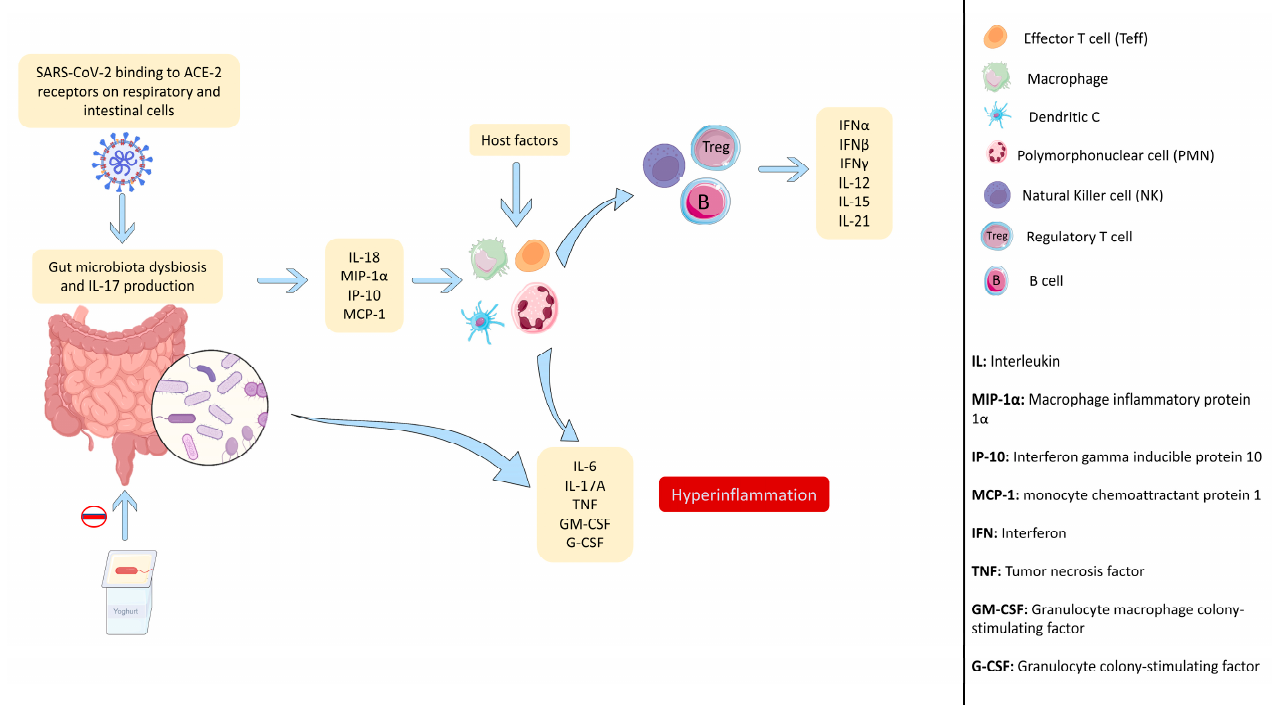
Figure 4. Mechanism of action of probiotics against SARS-CoV-2 infection. SARS-CoV-2 binds to ACE2 respiratory and intestinal cell receptors, producing dysbiosis of the intestinal microbiota. Probiotics can induce innate-immunity-activating cells, such as NK cells, polymorphonuclear (PMN) leukocytes, and macrophages, by means of the activity of cytokines, triggering responses with an immunomodulatory effect and also being capable of producing regulated inflammatory reactions through the action of cytokines.